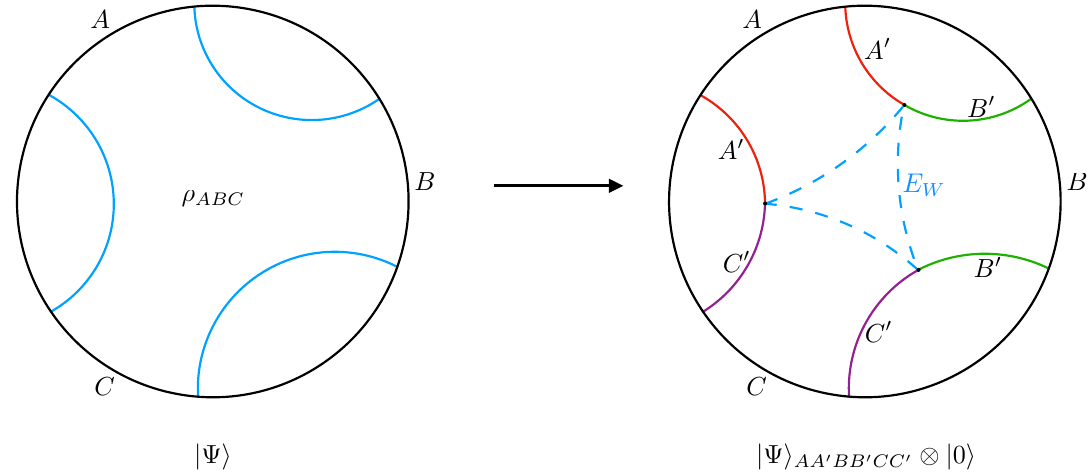
Figure 12 . Illustration of the pushing procedure. The entanglement wedge of ABC (bounded by the blue surfaces) is described by the reduced density matrix (cid:26) ABC in the left sub(cid:12)gure, while the entire boundary is described by the pure state j (cid:9) i . Using the surface-state correspondence and E P = E W conjecture in combination, we identify the tripartite entanglement wedge cross section (dashed blue line) and identify the purifying systems A 0 , B 0 , C 0 as living on the union of the portions of the Ryu-Takayanagi surfaces on the A , B , or C side of the entanglement wedge cross section, respectively (red, green, and purple surfaces). The full entanglement wedge is now described by j (cid:9) i AA 0 BB 0 CC 0 , while the extra boundary degrees of freedom unentangled with the entanglement wedge are described by some state j 0 i